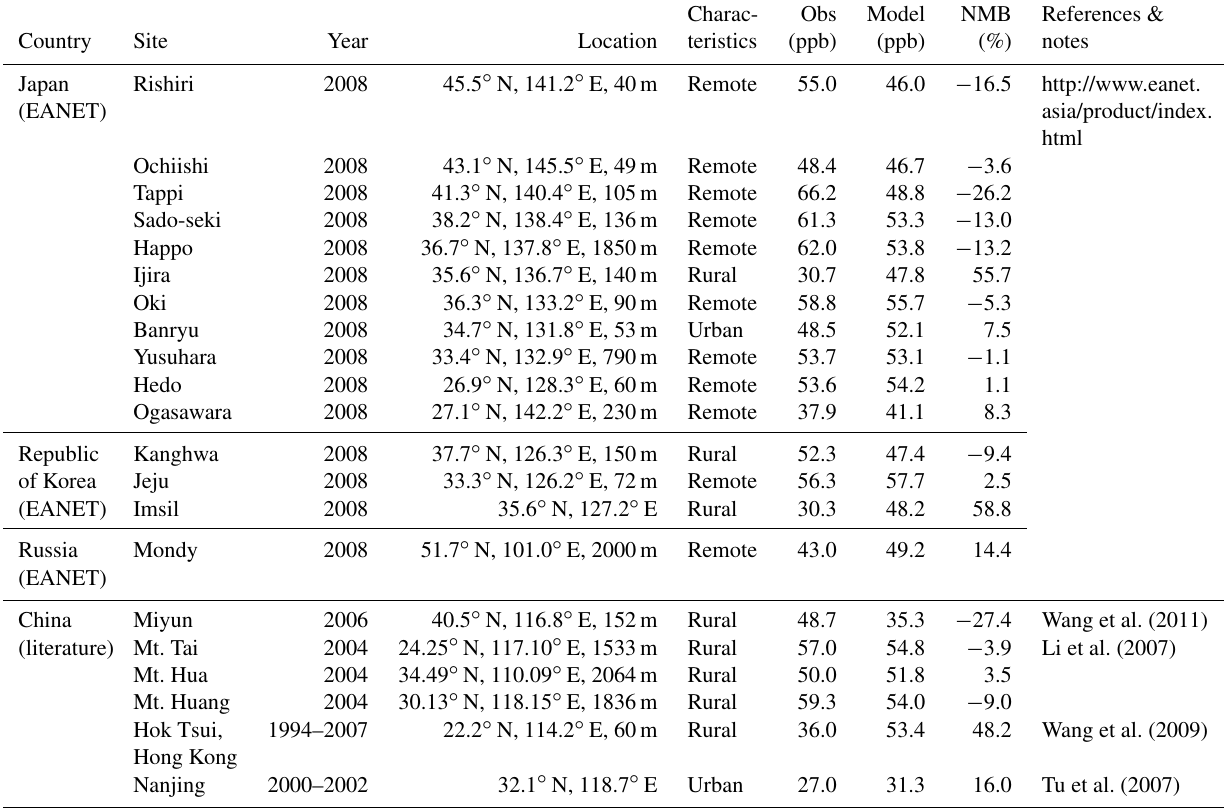
Table 4. Comparison of simulated springtime monthly mean ozone with observations from EANET and